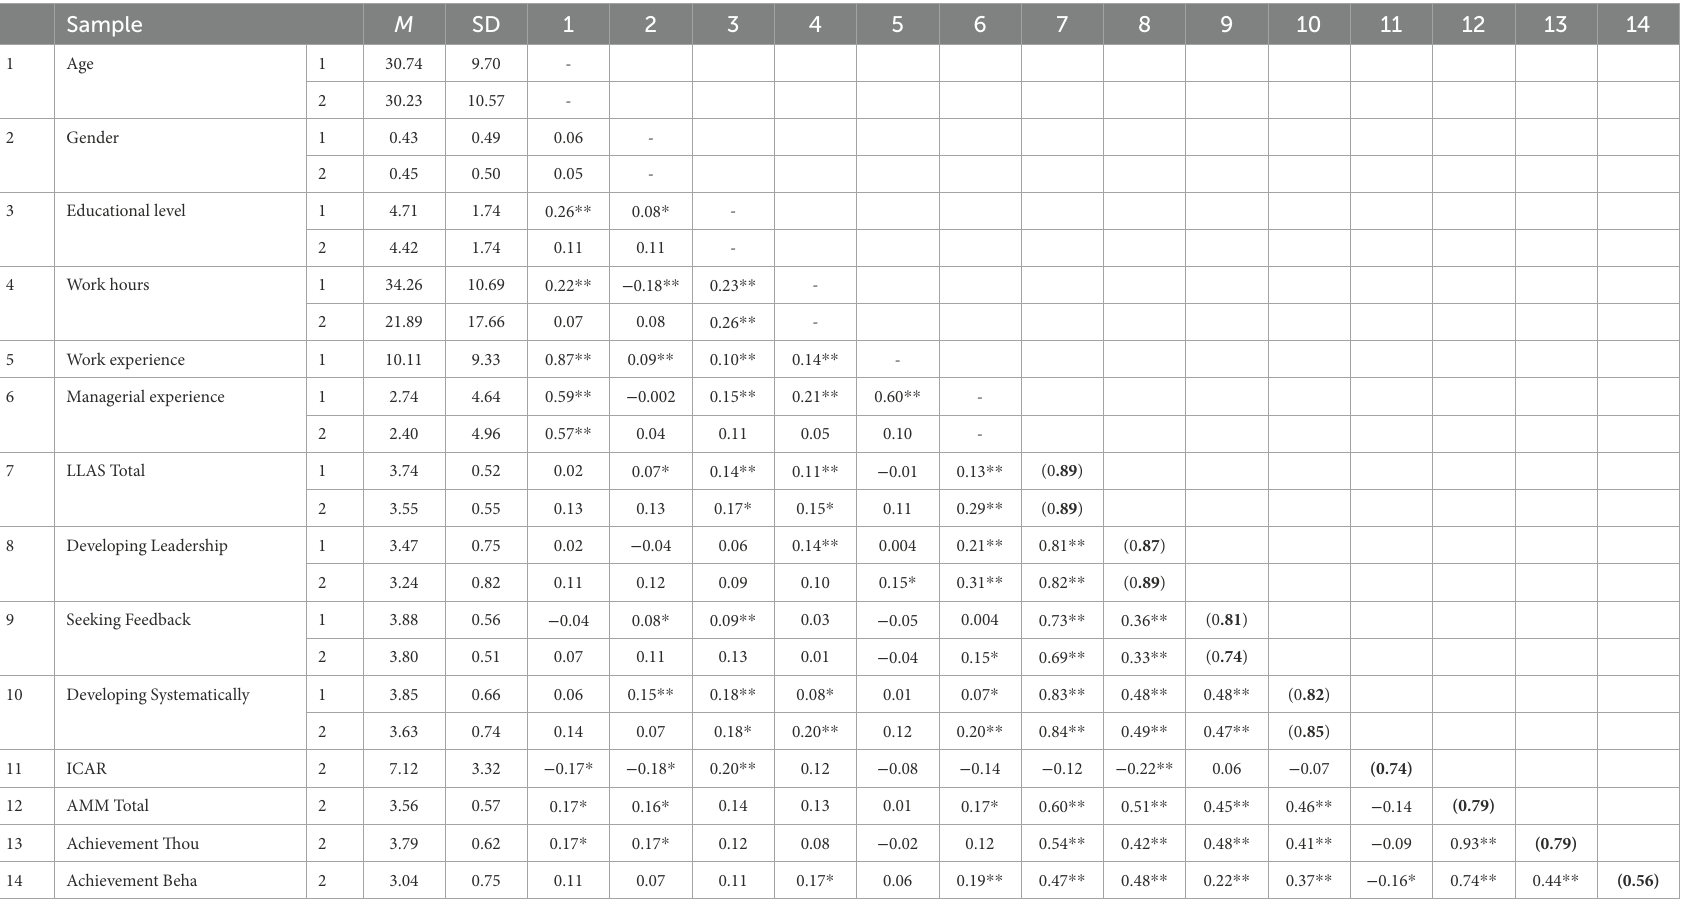
TABLE 3 Means, standard deviations, correlations, and internal consistencies of the study variables in sample 1 ( N = 907) and 2 ( N =